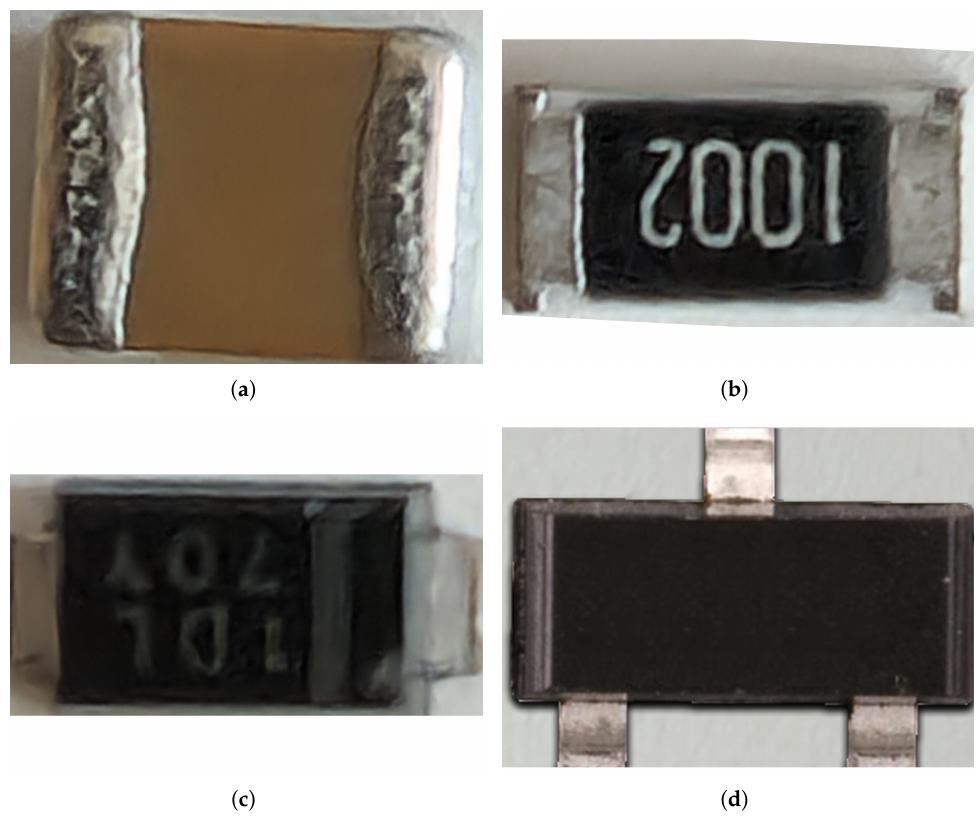
Figure 3. Four types of electronic components used for the dataset. ( a ) Capacitor, ( b ) resistor, ( c ) diode, ( d ) transistor.